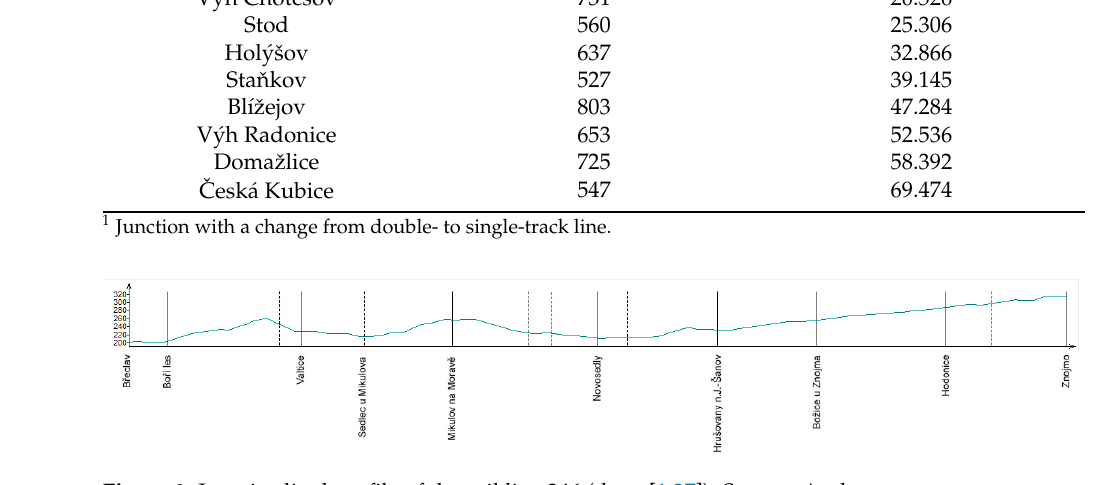
Figure 2. Longitudinal profile of the rail line 246 (data: [1,27]). Source: Authors. Table 2. Intermediate stations of the single-track section of the line 246 B ř eclav–Znojmo (data: